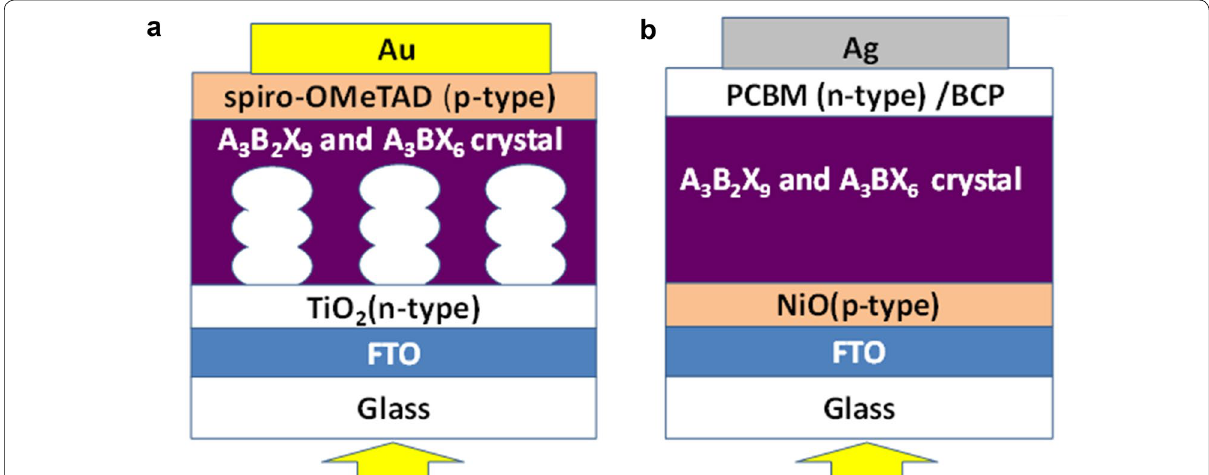
Fig. 1 Structures of fabricated solution processed lead-free A 3 B 2 X 9 and A 3 BX 6 crystal (A: monovalent cation; B: trivalent cation; X: halogen anion) solar cells: normal mesoscopic (n-i-p) ( a ) and inverted planar (p-i-n) ( b ) structures